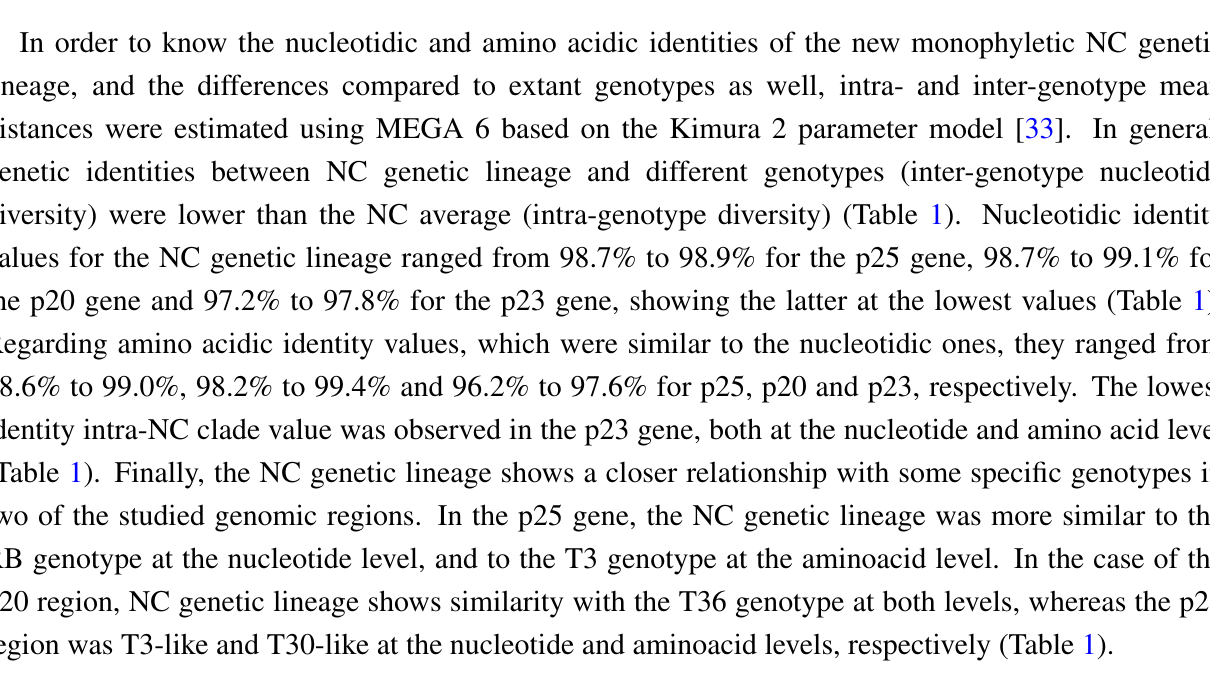
Table 1. Averaged nucleotide and amino acid identities for each region of the NC lineage and the comparison with other extant